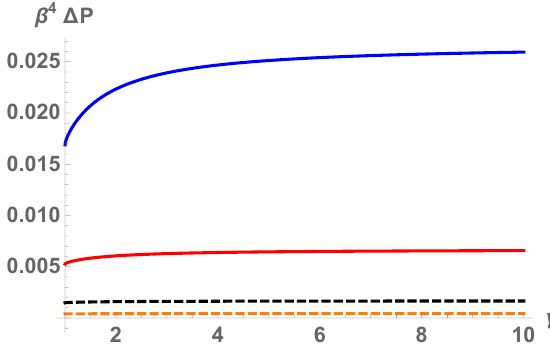
Figure 6 . The force on the bubble ∆ P z defined in (3.39) as a function of the Lorentz factor γ for m = 0 . 1 T (orange dashed), m = 0 . 2 T (black dashed), m = 0 . 4 T (solid red), and m = 0 . 8 T (solid blue). As expected, the force is smaller for smaller masses.